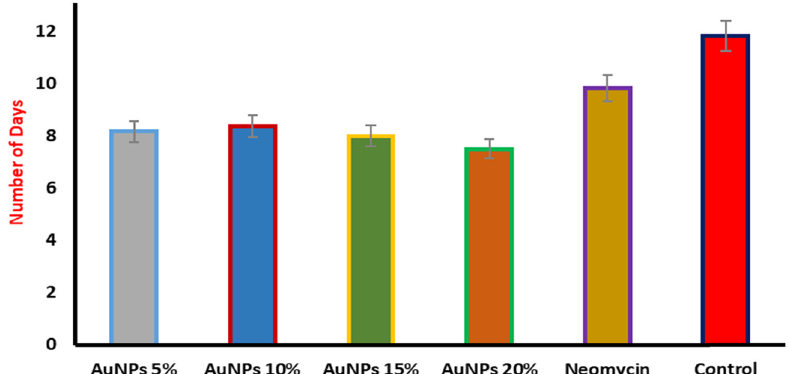
Figure 6: E ff ect of AuNPs on period of epithelialization in excision wound model.